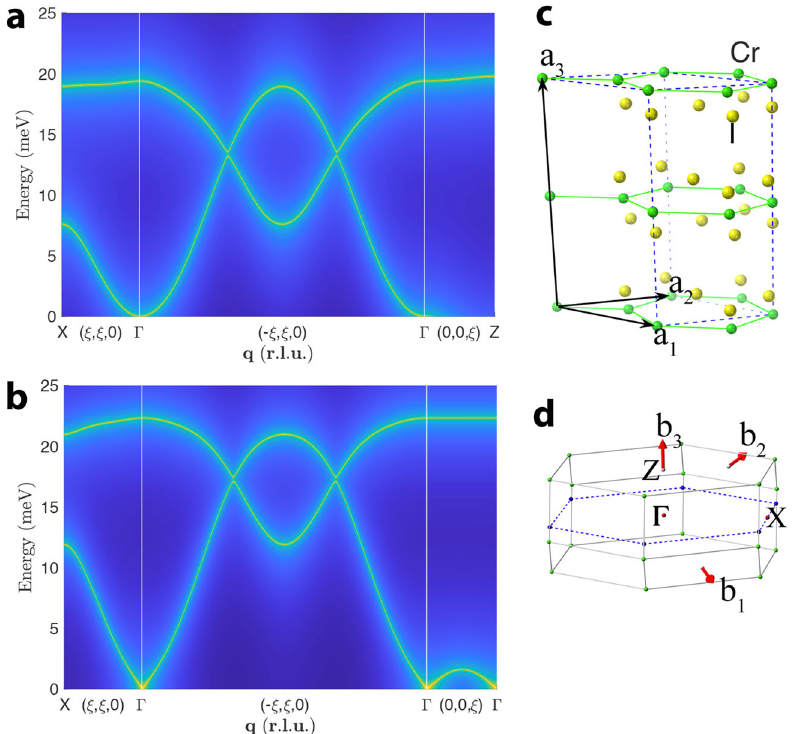
Fig. 4 SW spectra in FM and A -type AFM M-CrI 3 calculated within QSGW. Wavevectors q = h b 1 + k b 2 + l b 3 is denoted as q = ( h , k , l ) in reciprocal lattice units (r.l.u.). SW are plotted along X – Γ – Y – Γ – Z for the FM structure and X – Γ – Y – Γ – Z – Γ for the AFM structure. High-symmetry q points X , Y , and Z are at BZ boundaries and denoted as (0.5, 0.5, 0), ( − 0.5, 0.5, 0), and (0, 0, 0.5), respectively. a Im ½ χ q ; ω ð Þ(cid:2) calculated in FM con fi guration. b Im ½ χ q ; ω ð Þ(cid:2) calculated in AFM con fi guration. c The primitive cell of AFM M-CrI 3 structure, in which the lattice vector a 3 is doubled, in comparison to the FM structure. d The fi rst BZ of M-CrI 3 . Reciprocal lattice vectors b 1 and b 2 are the same for both FM and AFM ¼ 2 b ð AFM Þ structures, while b ð FM Þ 3